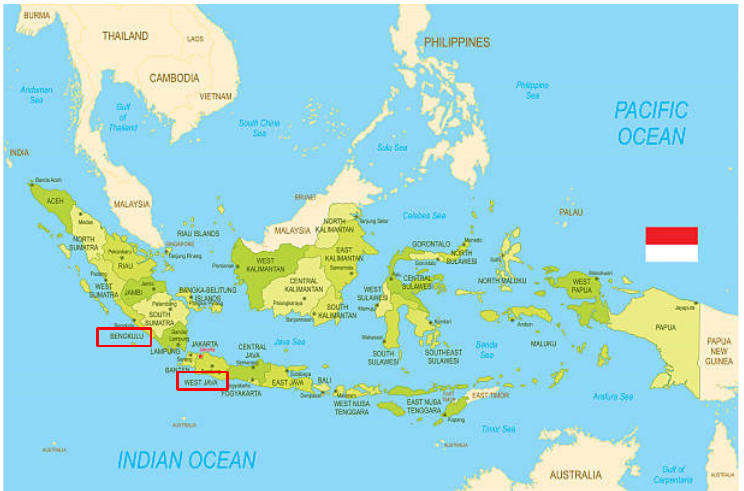
Figure 1. Survey locations.